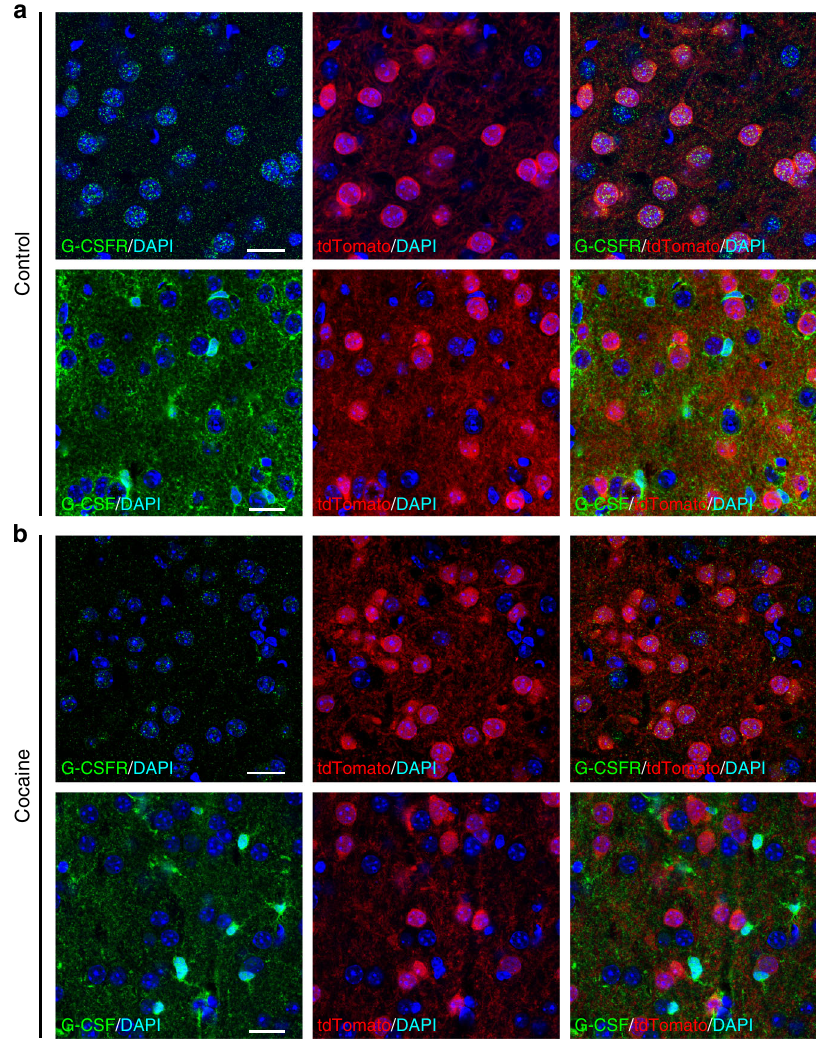
Fig. 4 Detection of G-CSF and G-CSFR in the NAc of D1-tdTomato mice. Immunolabeling for tdTomato protein and GCSFR or GCSF in D1-tdTomato mice was performed to determine cell-type expression in the NAc. a Representative confocal images acquired in the shell of the NAc from control animals, demonstrating expression of G-CSFR (upper) and G-CSF (lower) in multiple cell types. b Representative images from mice treated with cocaine (20 mg kg − 1 , i.p. × 7 days) again showing expression of G-CSFR (upper) and G-CSF (lower). For all images nuclei were counterstained with DAPI, tdTomato protein is labeled in red, G-CSF and G-CSFR are labeled in green. Scale bar = 20 µ